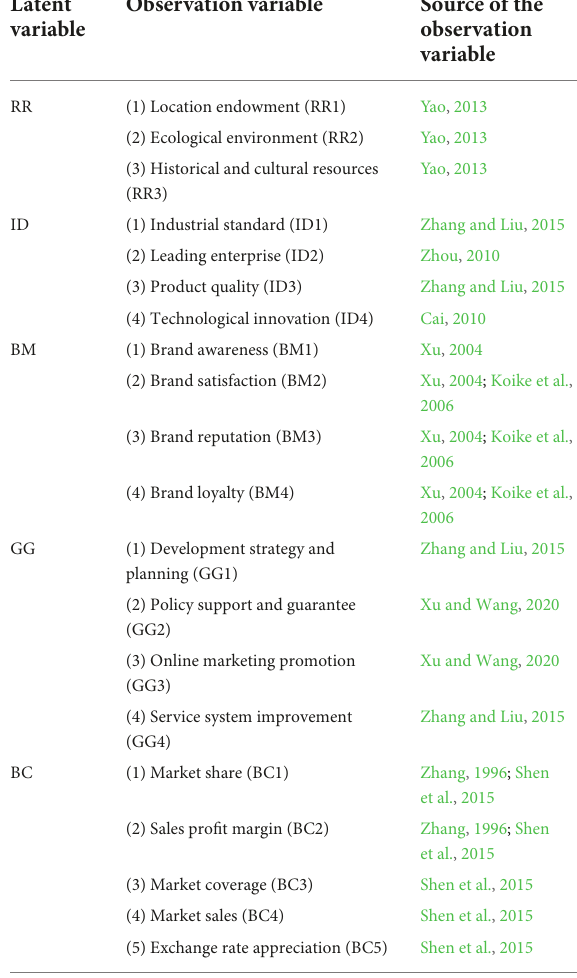
TABLE 1 Measured items and their